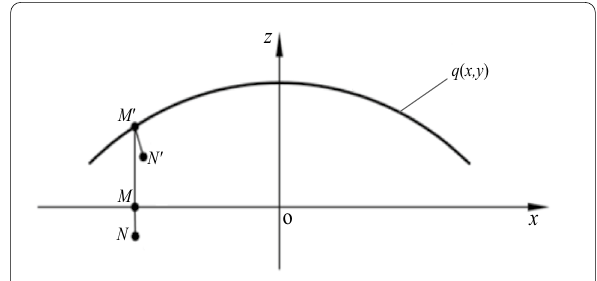
Figure 6 Deformation process of a point in the the atomization experiment of the medical piezoelectric atomization device induced by intra-hole fluctuation. Figure 3 shows the structure and parameters of the atomizer piece. It can be seen from Figure 3 that the pie- zoelectric vibrator is composed of dispenser and piezo- electric ceramic ring. The outer diameter, inner diameter, and thickness of the piezoelectric ceramic ring are set as values of 15.96 mm, 7.69 mm and 0.63 mm, respectively, while the diameter and thickness of the dispenser are 15.96 mm and 0.05 mm respectively. The taper holes with diameter of 740 μm were machined in the center area of the piezoelectric atomizer.